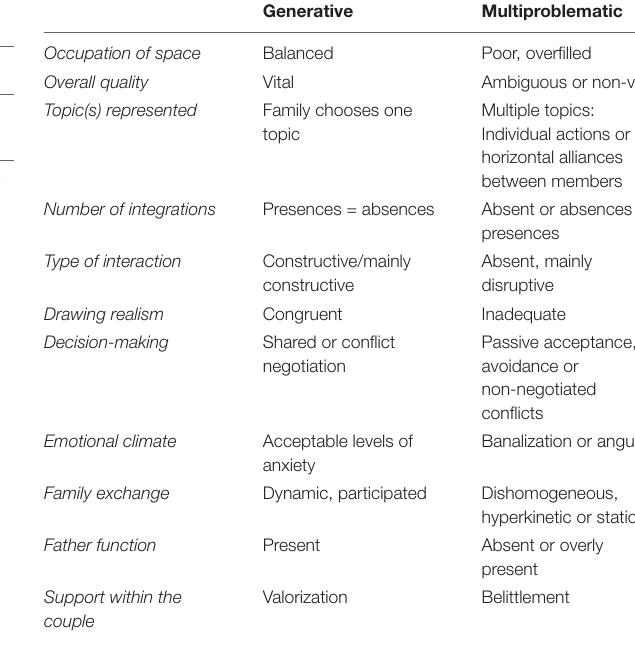
TABLE 5 | Prototypical